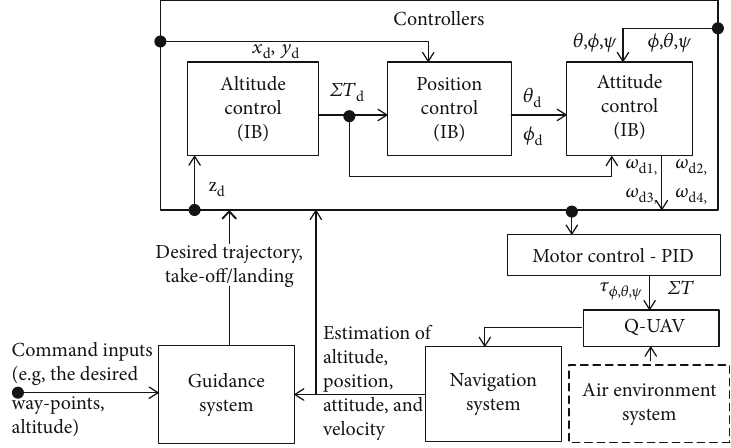
Figure 5: A functional block diagram for implementing the continuous evolutions of the Q-UAV